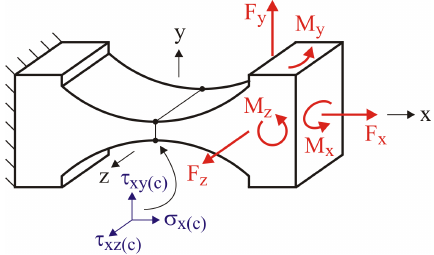
Figure 3. Relevant stress components on the corners of the thinnest cross section for the different cases of loading and deformation in a flexure hinge ( x – longitudinal axis, y – lateral axis, z – pivot